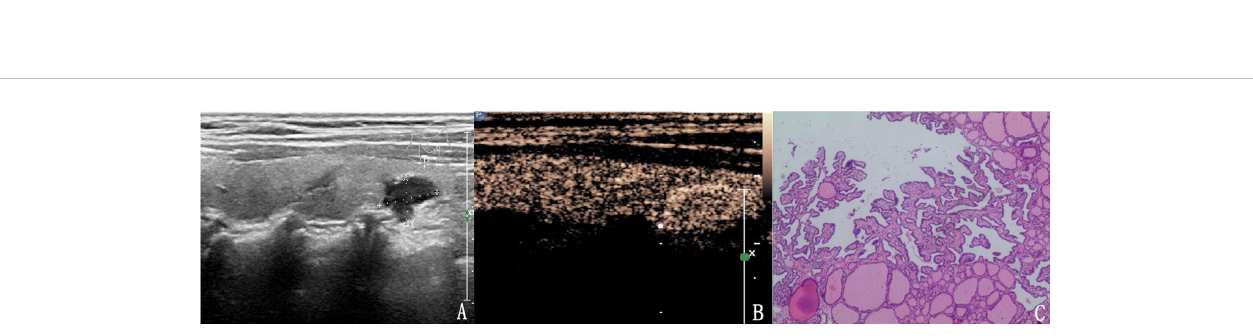
FIGURE 4 The case of a 64-year-old woman with a 10.6 × 6.7 × 5.9 mm solid mark hypo-echoic nodule in the right lobe of the thyroid. (A) Conventional two- dimensional image showing that the nodule had three malignant indicators (solid, mark hypo-echoic and irregular margin) and was classi fi ed with a TI- RADS score of 4b. (B) Ultrasound contrast image showing high enhancement. The modi fi ed version of the TI-RADS combined with CEUS returned a score of 4a, and the diagnosis was a benign nodule. (C) Pathological image of the lesion, a nodular goiter.